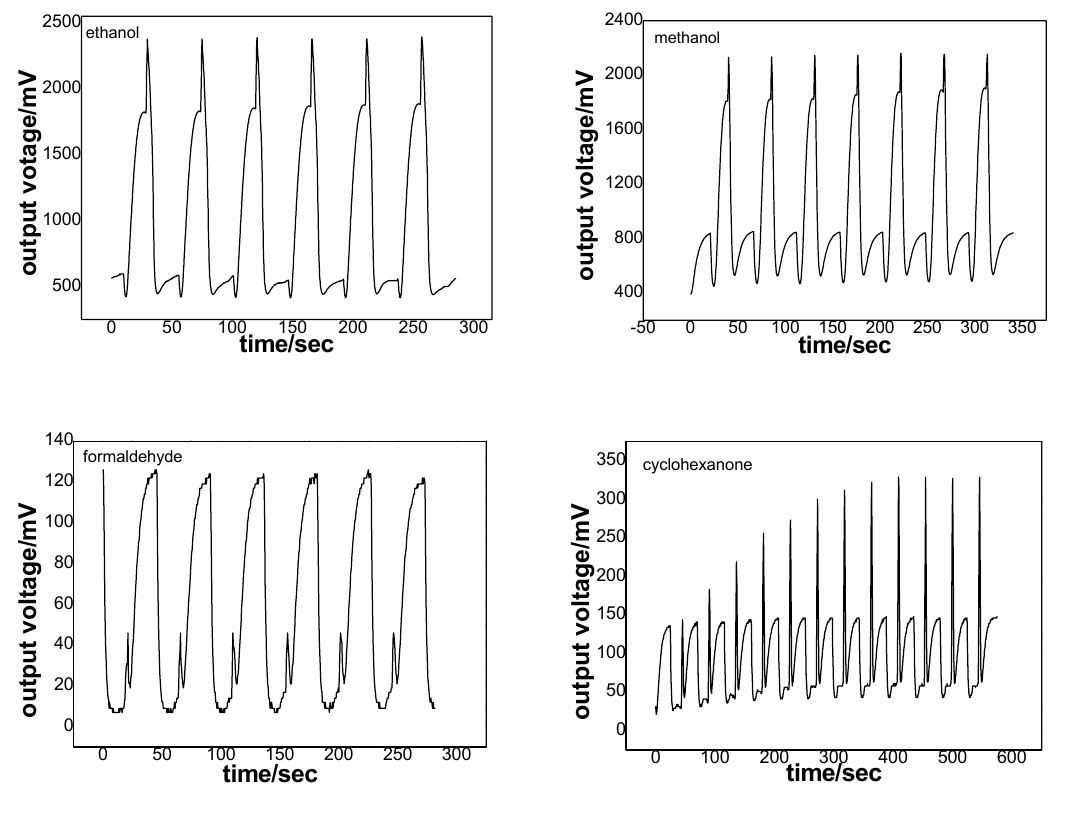
Figure 3. Dynamic nonlinear responses to ethanol, methanol, formaldehyde and cyclohexanone. Experimental conditions: sampling dosage 0.5 ppm, applied potential 7 V, modulation frequency 20 mHz, rectangular temperature